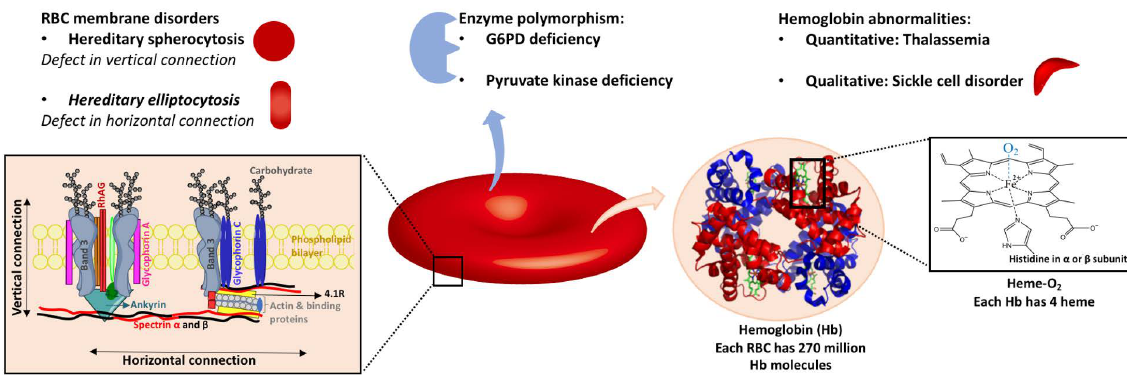
Figure 2. Common genetic abnormalities affecting RBC quality include hemoglobin abnormalities, enzyme defects and RBC membrane disorders. The RBC membrane structure is simplified for clarity. The hemoglobin 3D structure was obtained from the Protein Data Bank-free access.